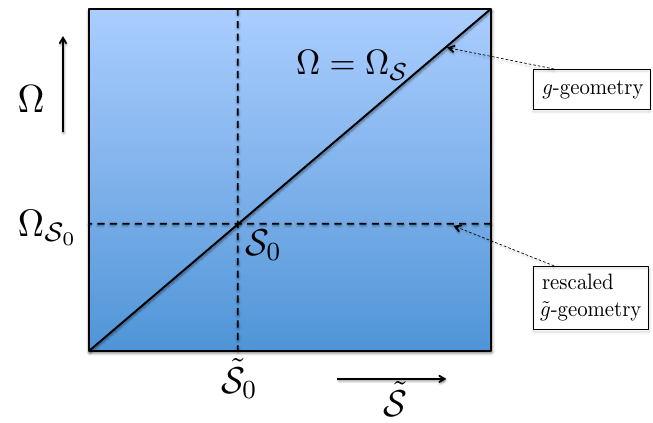
Figure 3 . The family of rescalings of the geometry ~ g contains the geometry g as a ‘diagonal’ described by the equation (cid:10) = (cid:10) (cid:10) ~ g . On the holographic screen S 0 this process for all values of (cid:10) a foliation of the geometry g is constructed and represented by the